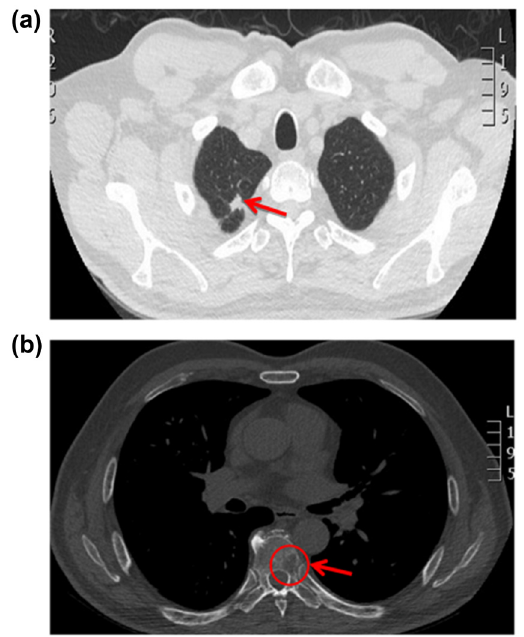
Figure 1: Imaging of the lung before diagnosis. ( a ) Consolidation of the lesion in the right upper lobe ( May 2017 ) . ( b ) Signi fi cantly damaged seventh thoracic vertebral bone ( May 2017 )